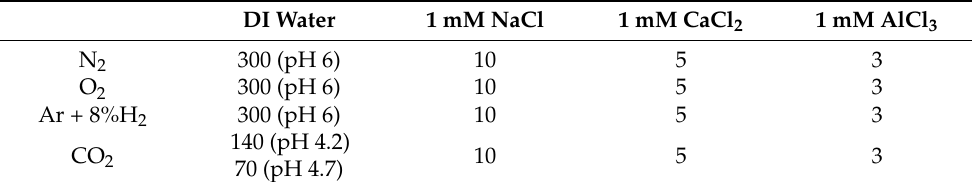
Table 3. Debye length (1/ κ , nm) of nanobubbles prepared in aqueous solutions at natural pH.